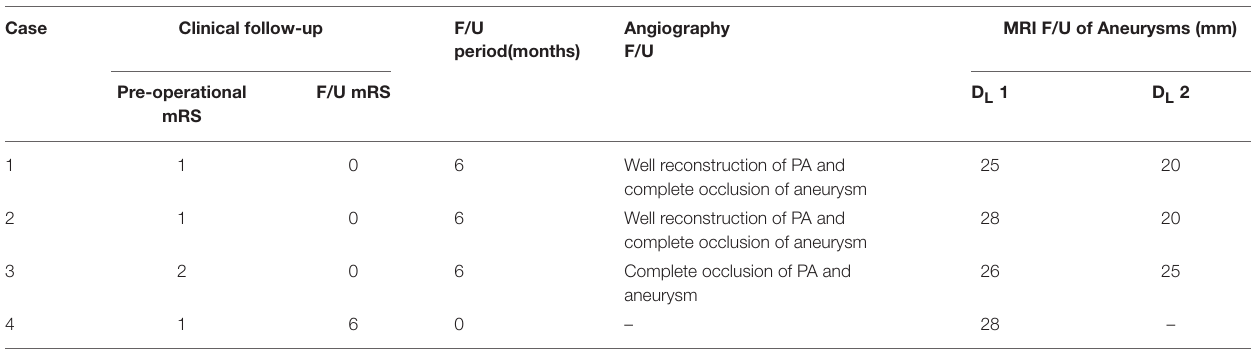
TABLE 2 | Angiographic and clinical follow-up